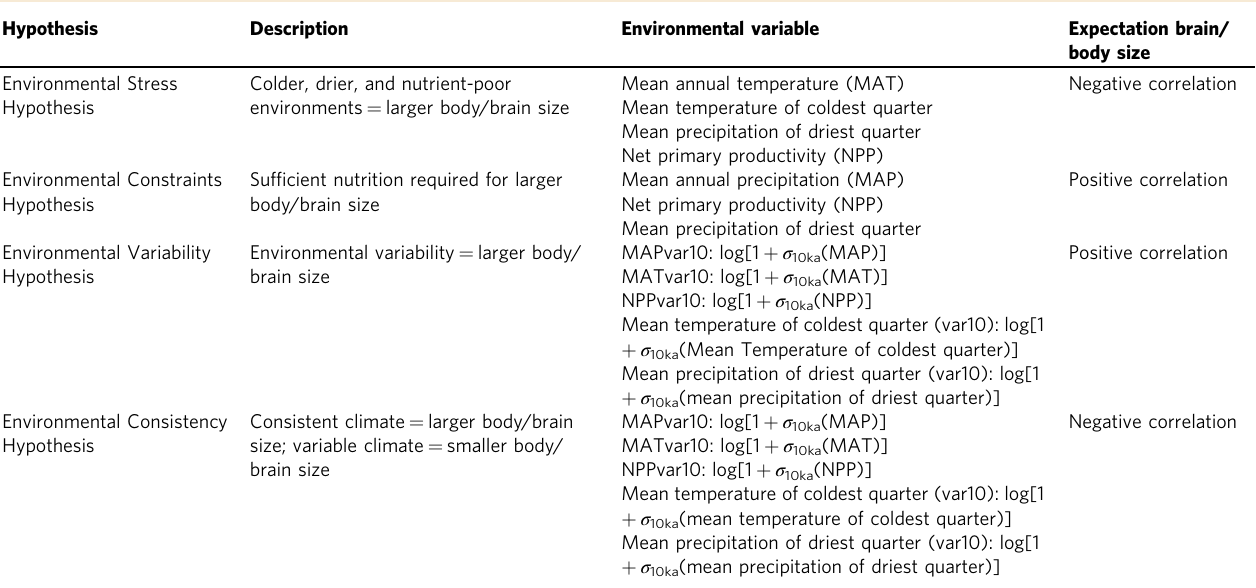
Table 1 Formalized environmental hypotheses for changes in brain and body size in Homo